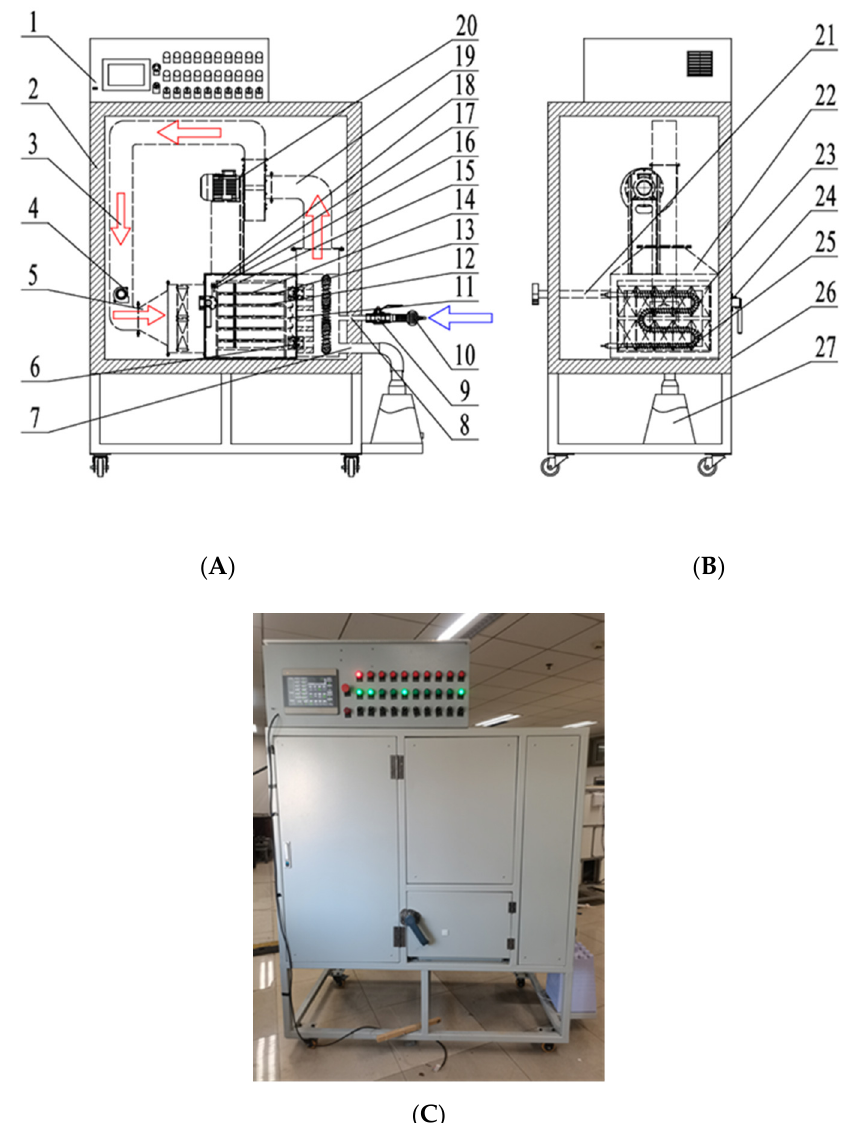
Figure 1. Schematic diagram of the overall structure of a multi-layer box-type hot air dryer based on temperature and humidity control: ( A ) main view of dryer; ( B ) left view of the dryer; ( C ) physical drawing of the dryer. 1. control system; 2. insulation layer; 3. air inlet duct; 4. dehumidification fan; 5. bell mouth; 6. door hinge; 7. humidification port; 8. air inlet port; 9. manual ball valve; 10. dehumidification devices; 11. thrusting needle PT100 temperature sensor; 12. tray; 13. carbon-crystal infrared heating plate; 14. surface mount PT100 temperature sensor; 15. material rack; 16. SHT35 temperature and humidity sensor; 17. probe-type PT100 temperature sensor; 18. drying chamber; 19. return air duct; 20. centrifugal blower; 21. drainage pipe; 22. heating chamber; 23. axial flow fan; 24.